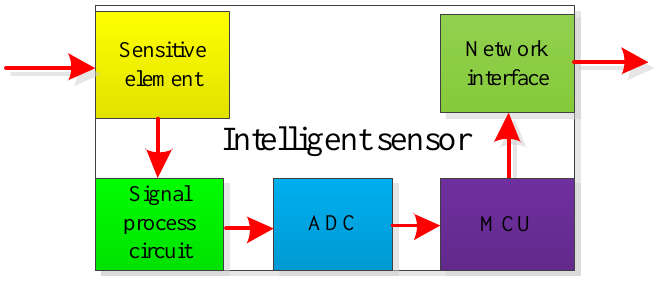
Figure 9. Structure chart of intelligent sensors.